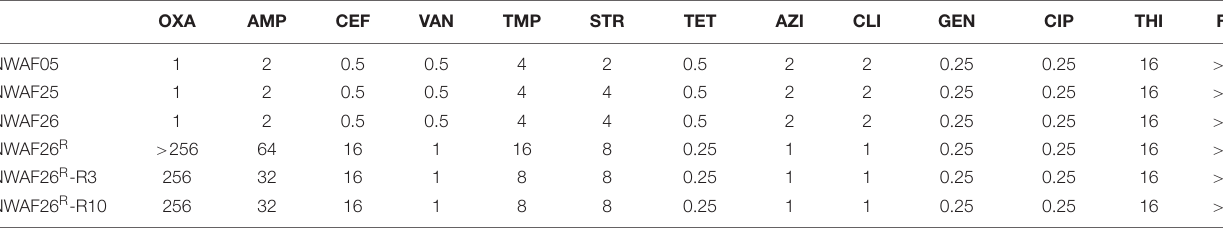
TABLE 3 | Minimal inhibitory concentration (MIC) of antibiotics to Staphylococcus sciuri. OXA AMP